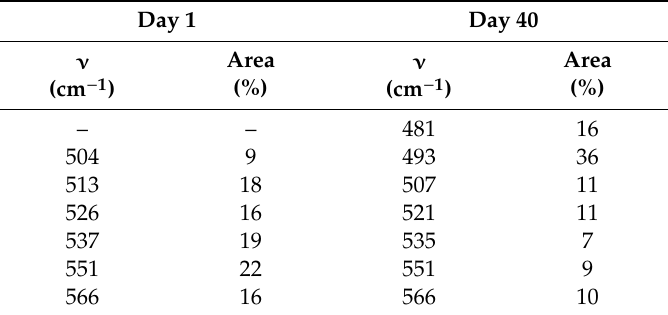
Table 3. The population of each conformer, calculated as the fraction of its band area from the total area of the bands.